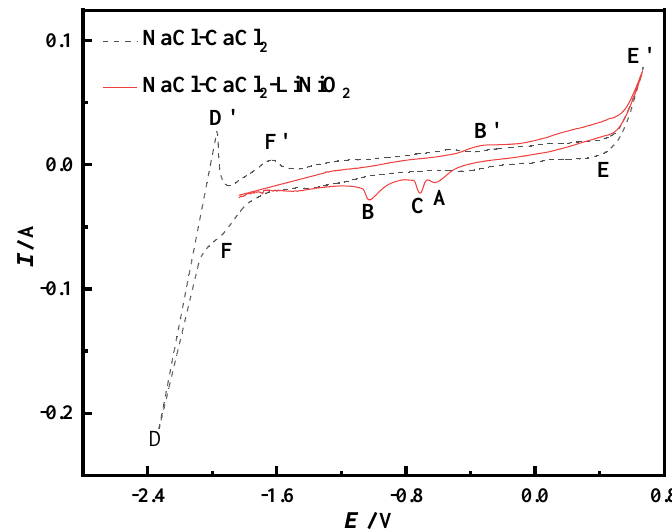
Figure 1. Cyclic voltammogram of Mo electrode before and after adding LiNiO 2 to NaCl-CaCl 2 molten salt (scanning speed: 0.25 V/s, T = 750 °C, reference electrode: Pt electrode).